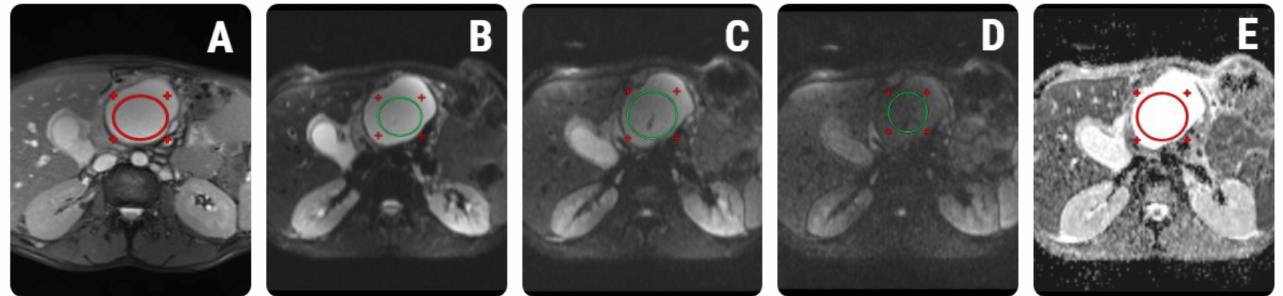
Figure 1. Quantitative signal intensity measurements using regions of interest (ROIs) placed on: ( A ) T2- weighted images (red ellipsoid); ( B – D ) three diffusion-weighted (DWI) sequences acquired at different b-values (green ellipsoids); and ( E ) apparent diffusion coefficient (ADC) maps (red ellipsoid). The examination belongs to a 43-year-old patient who developed pseudocysts after an episode of pancreatitis.